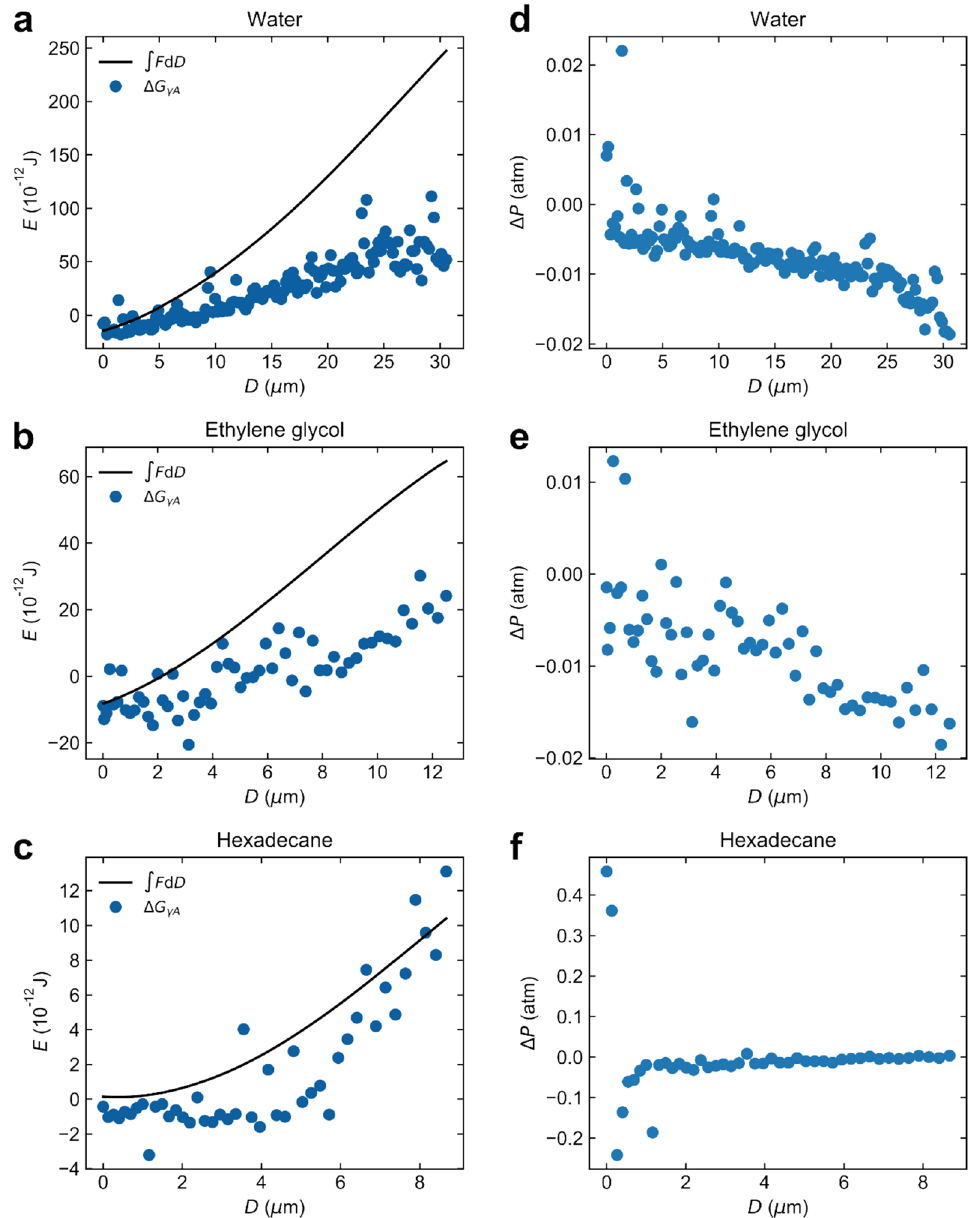
Figure 6. The free energy change due to gas capillary formation evaluated from the integral of the force- distance curve ∫ F d D measured on retraction (solid black line) compared to the surface tension-area work Δ G γA calculated using Eq. (1) (blue symbols) for measurements in ( a ) water, ( b ) ethylene glycol and ( c ) hexadecane. The piezo expansion rate was 0.2 µm s −1 . The pressure difference across capillary gas–liquid interface Δ P F d D − � G γ A calculated from the difference between ∫ F d D and Δ G γA in ( a – c ) as � P = − (cid:31)